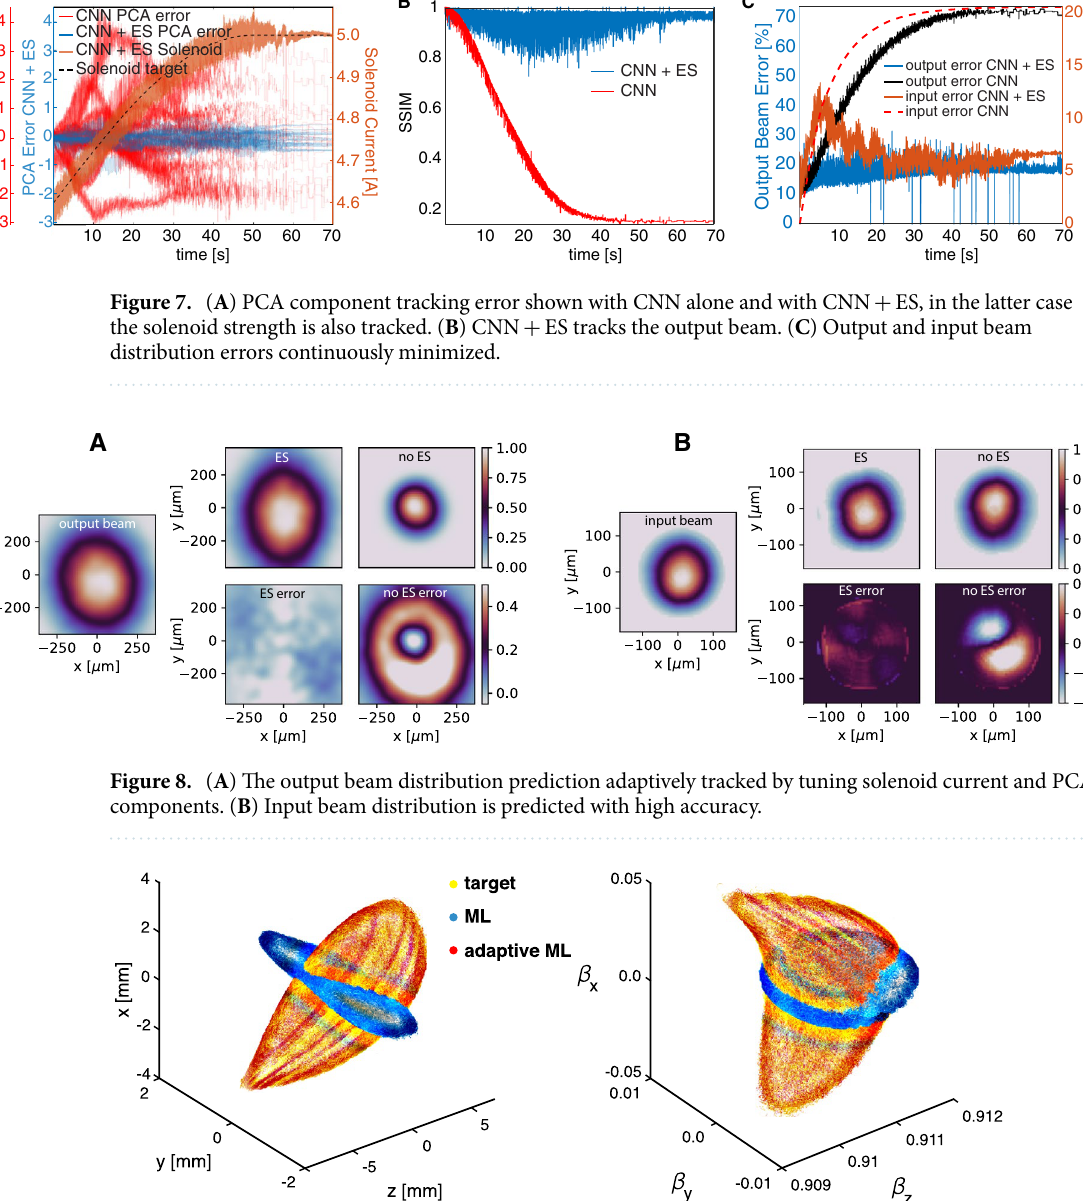
Figure 9. 6D phase space predictions with and without adaptive